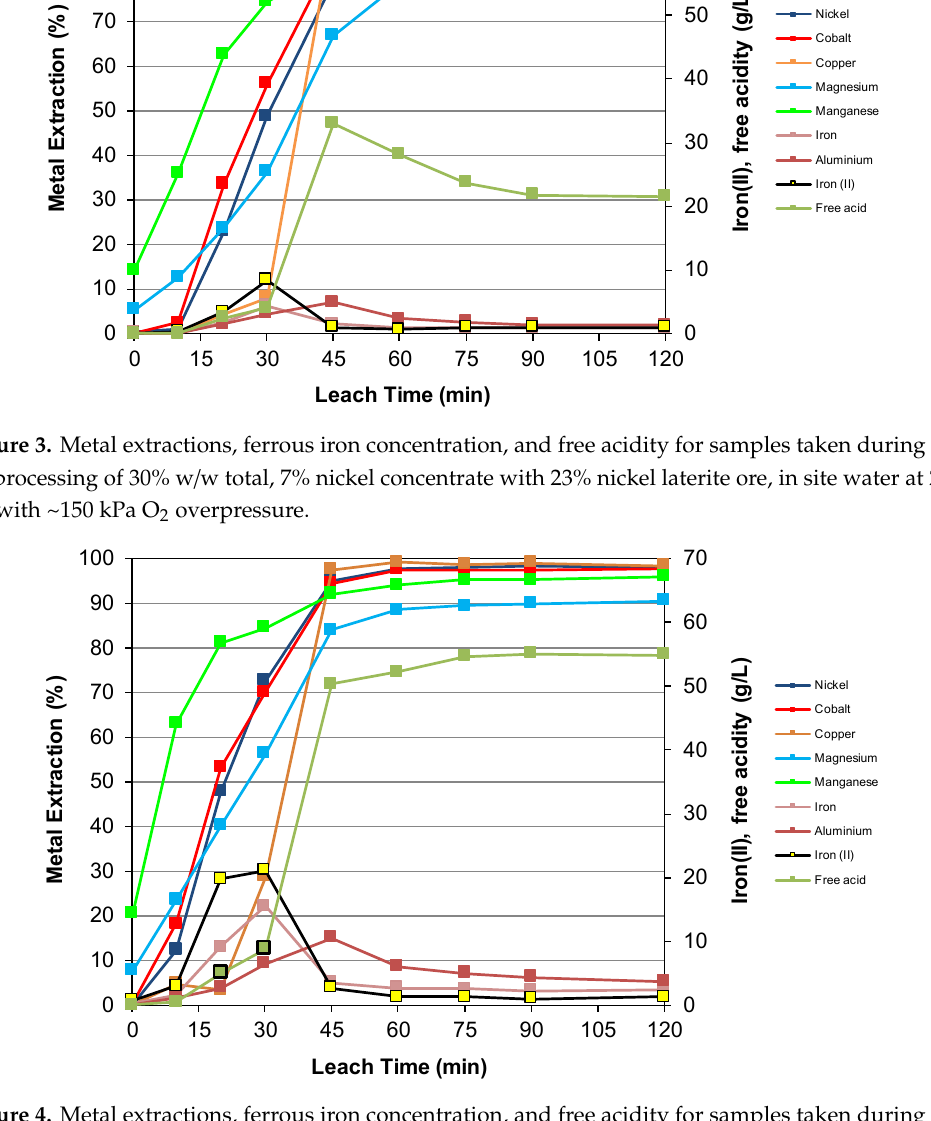
Figure 4. Metal extractions, ferrous iron concentration, and free acidity for samples taken during the co-processing of 30% w / w total, 10.5% nickel concentrate with 19.5% nickel laterite ore, in site water at 250 °C with ~100 kPa O 2 overpressure.